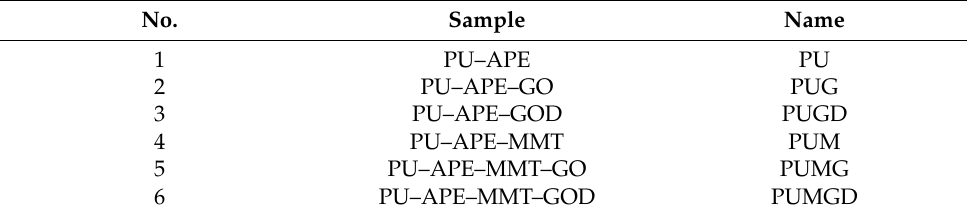
Table 1. Abbreviations used for polyurea formulations prepared.